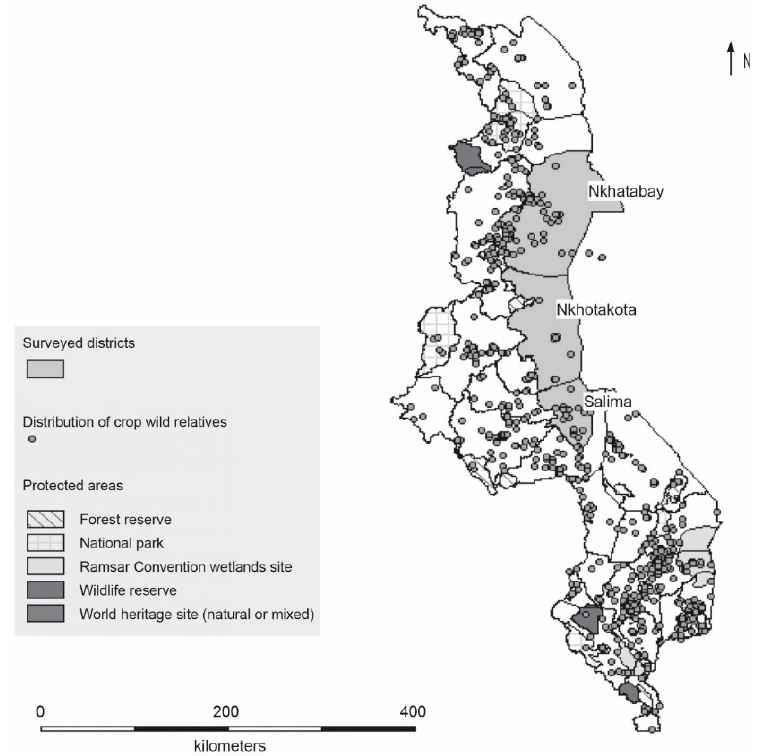
Figure 1. Project sites and distribution of crop wild relatives in Malawi.